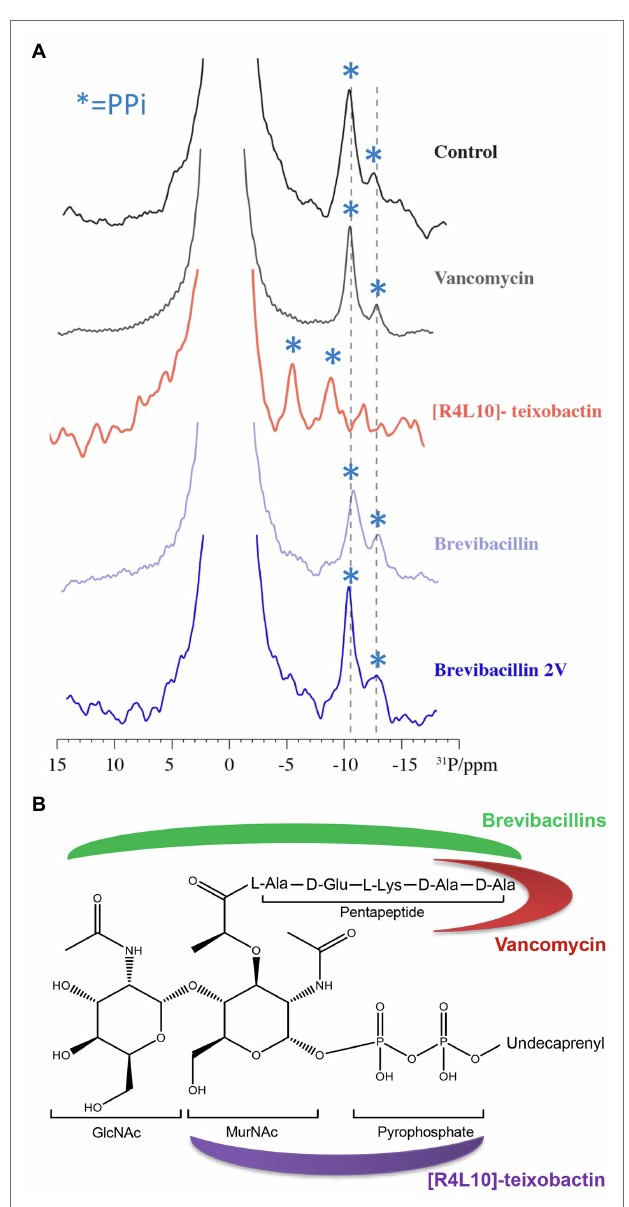
FIGURE 8 | Brevibacillins likely bind to the GlcNAc-MurNAc moiety and/or the pentapeptide of Lipid II. (A) , 1D 31 P spectra of Lipid II in liposomes in the presence of vancomycin, [R4L10]-teixobactin, brevibacillin, and brevibacillin 2V. Blue asterisks mark PPi signals; bulk lipids come around 0 ppm. (B) , Structure of Lipid II (Münch and Sahl, 2015; Shukla et al., 2020). Red moon indicates the Lipid II-binding site of vancomycin; purple moon indicates the Lipid II-binding site of [R4L10]-teixobactin; and green moon indicates the likely Lipid II-binding site of